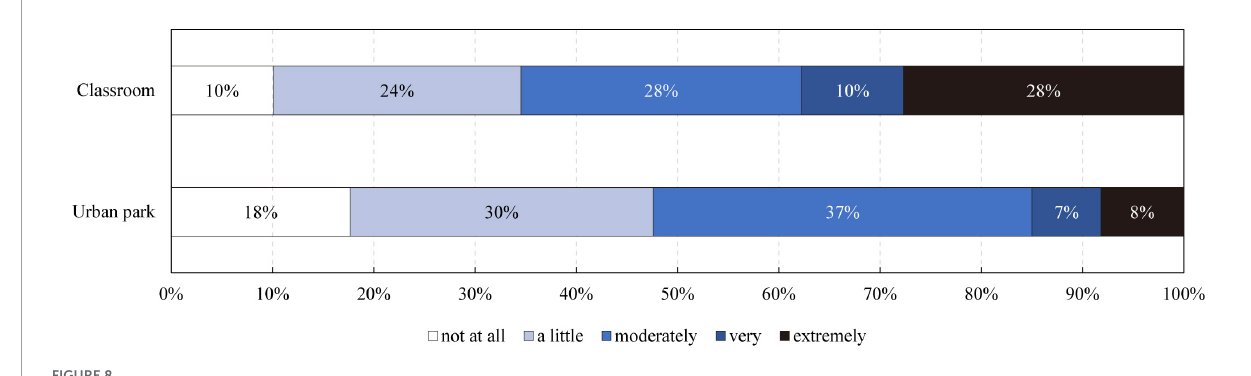
FIGURE8 Difference in sound environment importance.